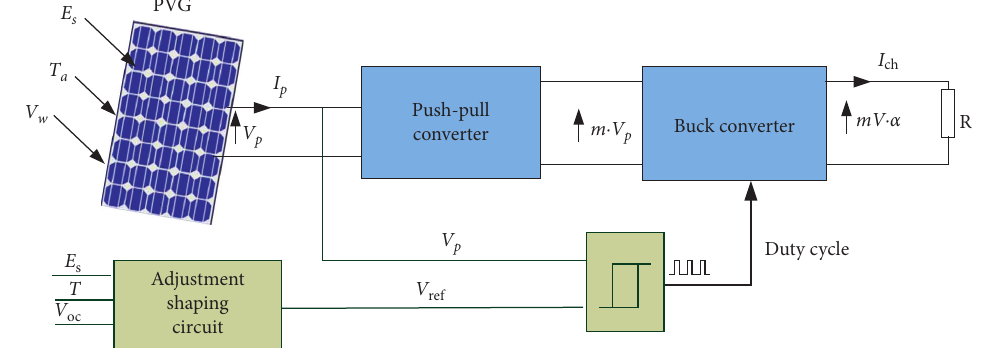
Figure 16: Circuit of the studied system.